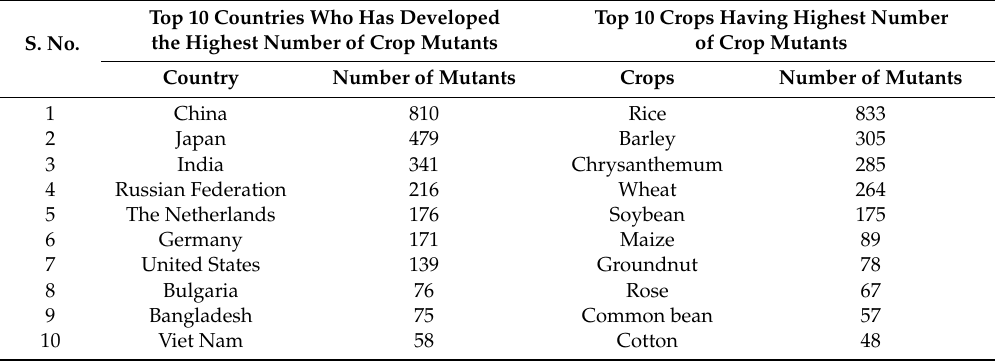
Table 1. Crop wise and country wise status of crop mutants in the world S.